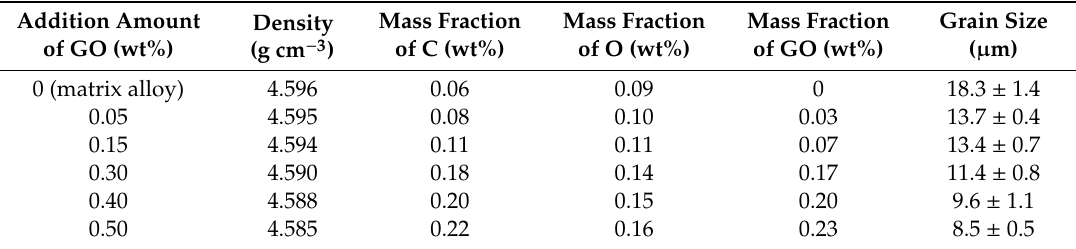
Table 2. Characteristics of GO-reinforced high-temperature titanium-alloy-matrix composites.